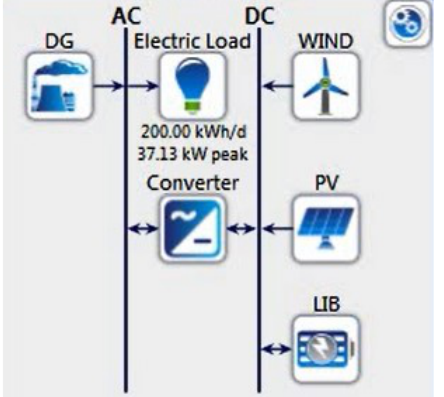
Figure 9. Schematic representation of hybrid power generation